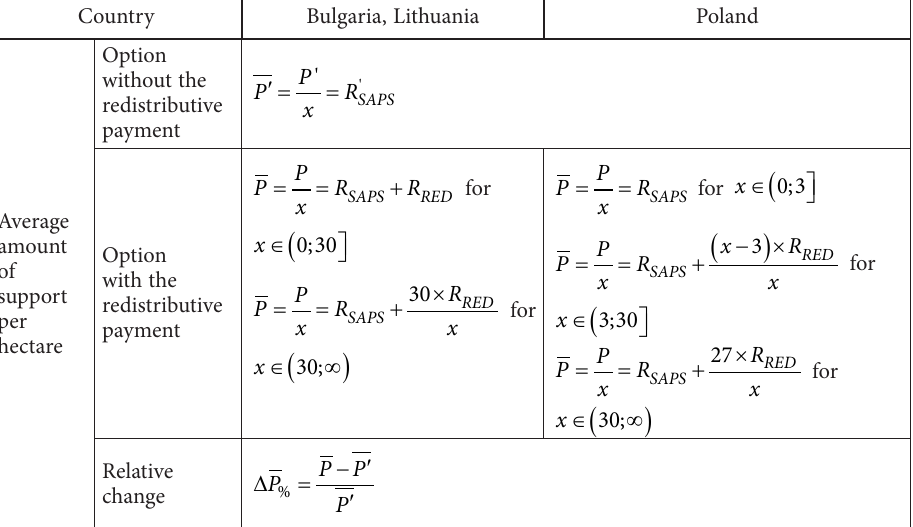
Table 3. Determination of the average amount of holding support, depending on its size (source: au- thor’s own work)